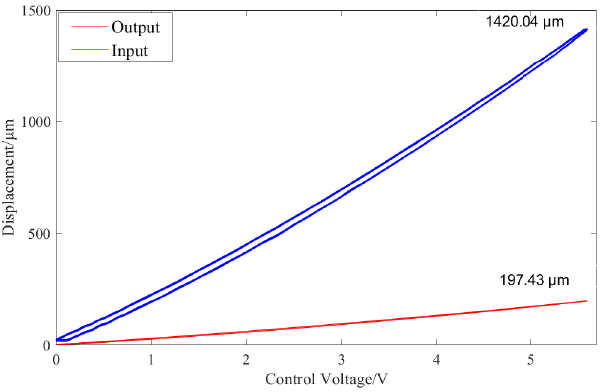
Figure 9. The relationship between the input and output displacements and the control